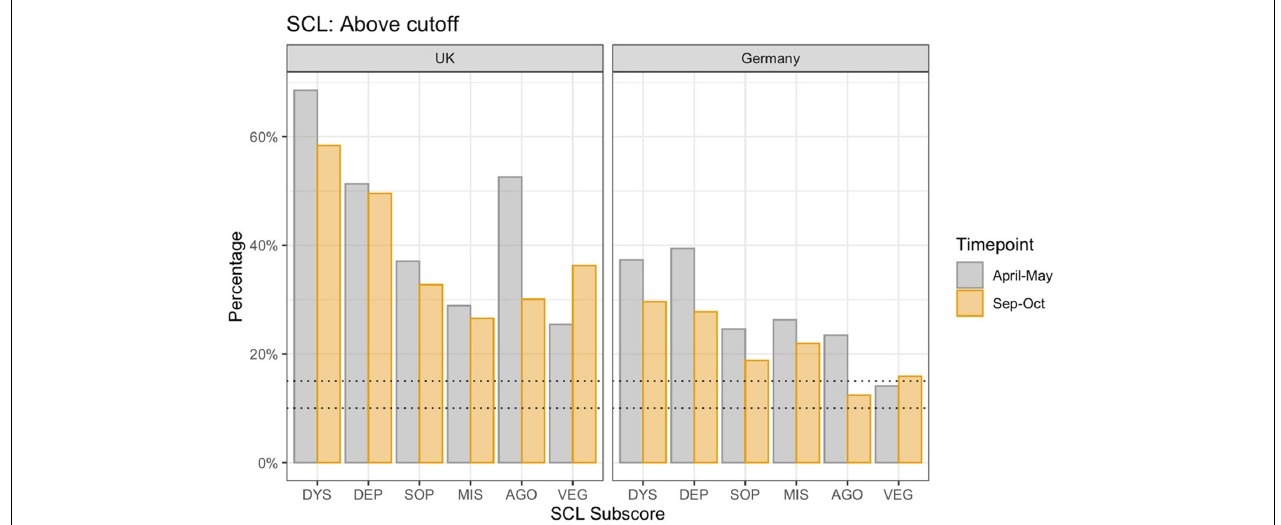
FIGURE 2 | Percentage of responders above clinical cut-off by country and sample. Dotted lines represent the percentage of the norm population above threshold (10–15%). DYS: dysthymic symptoms, DEP: depressive symptoms, SOP: symptoms of social phobia, MIS: symptoms of mistrust, AGO: agoraphobic symptoms, VEG: vegetative symptoms.